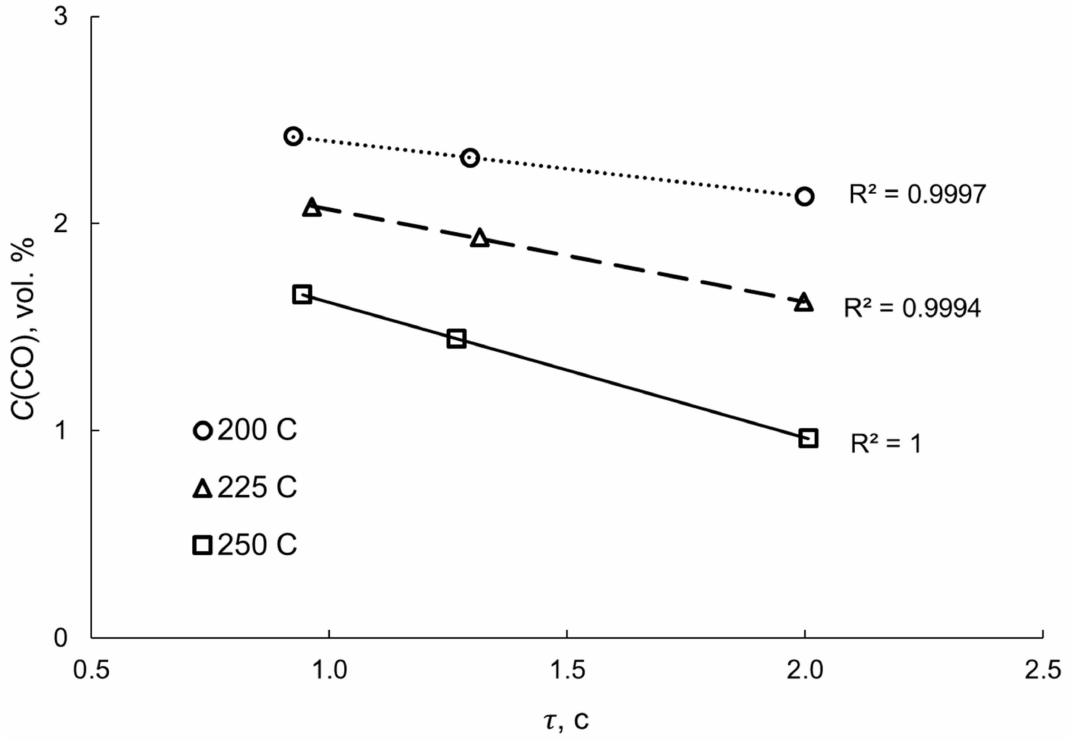
Figure 15. Dependence of the concentration of carbon monoxide on the conditional contact time for the process of hydrogenation of model mixture No.